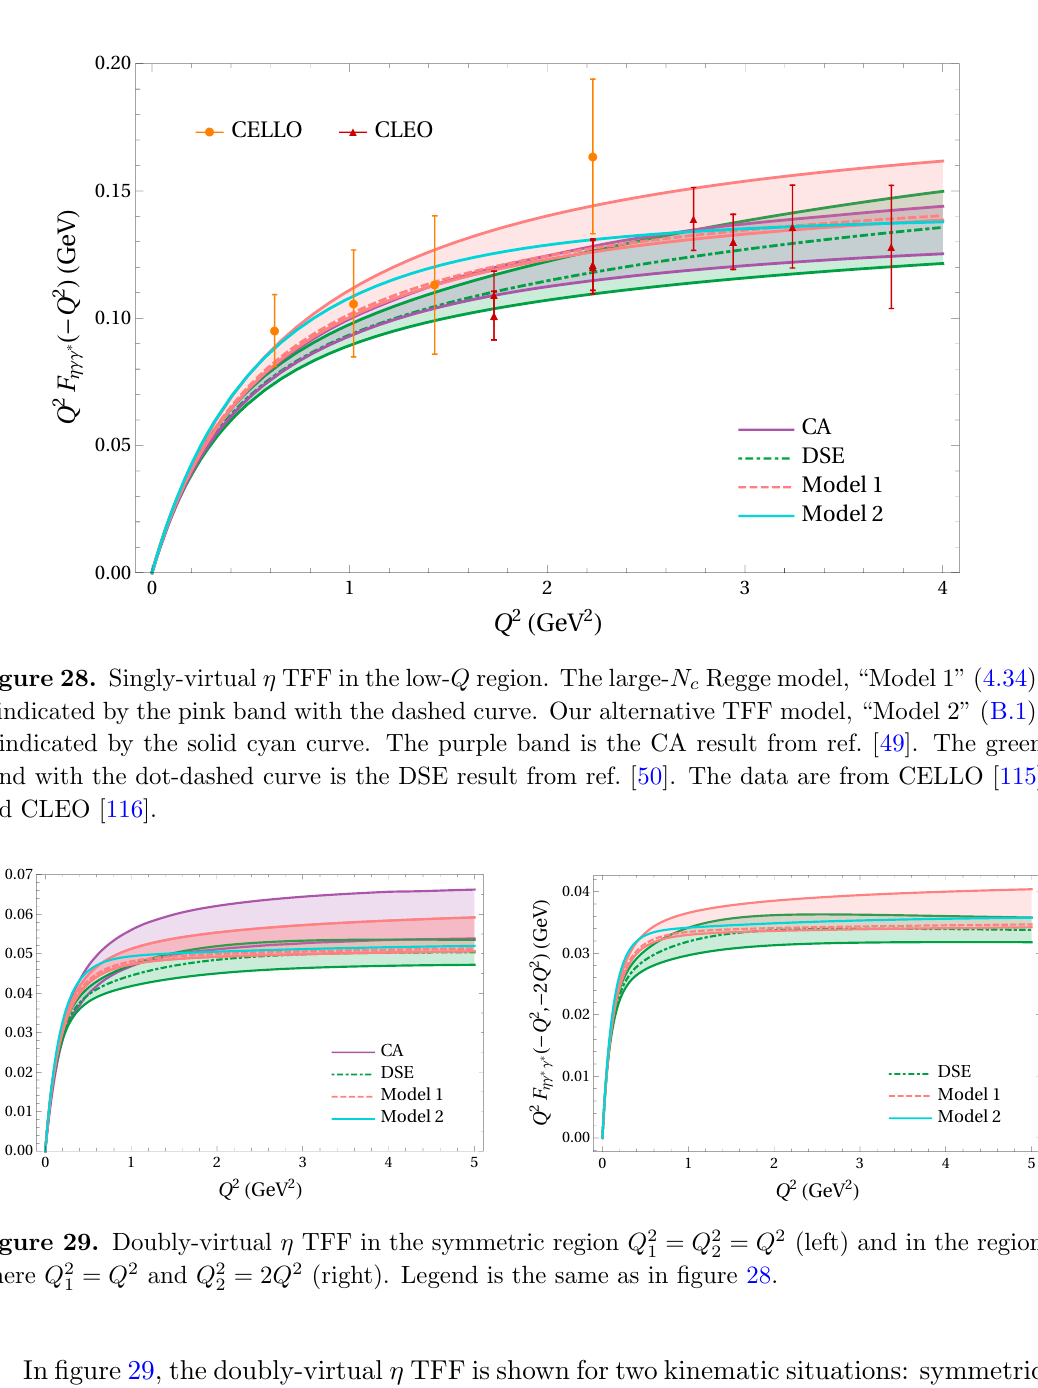
= Q 2 = Q 2 (left) and in the region 1 2